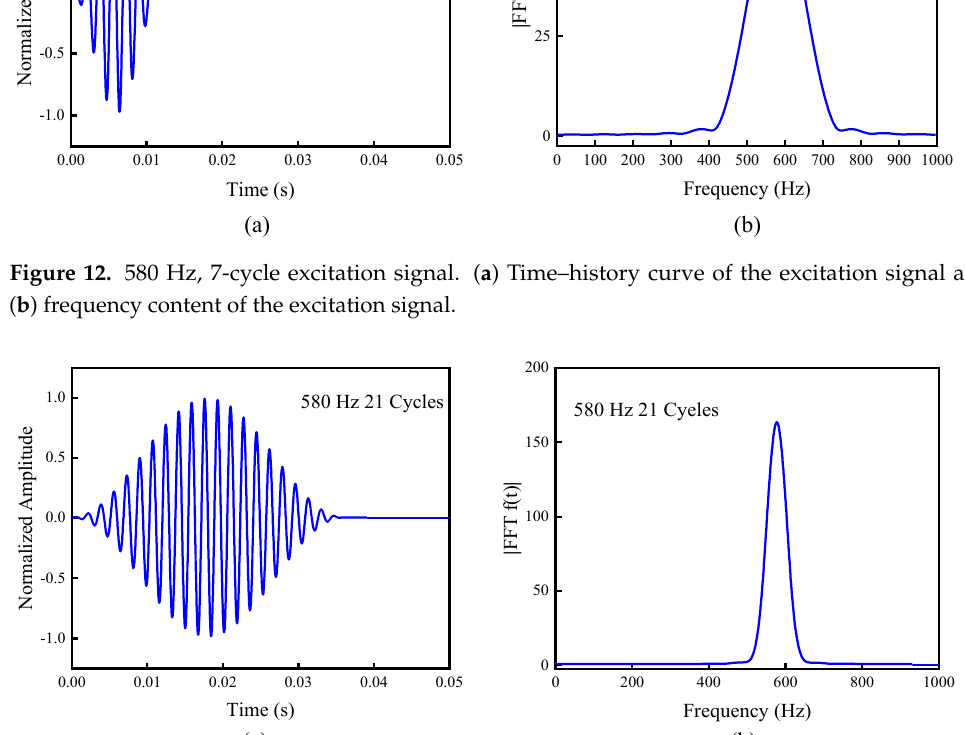
Figure 12. 580 Hz, 7-cycle excitation signal. ( a ) Time–history curve of the excitation signal and ( b ) frequency content of the excitation signal. Figure 13. 580 Hz, 21-cycle excitation signal. ( a ) Time–history curve of excitation signal and ( b ) fre- quency content of excitation signal.